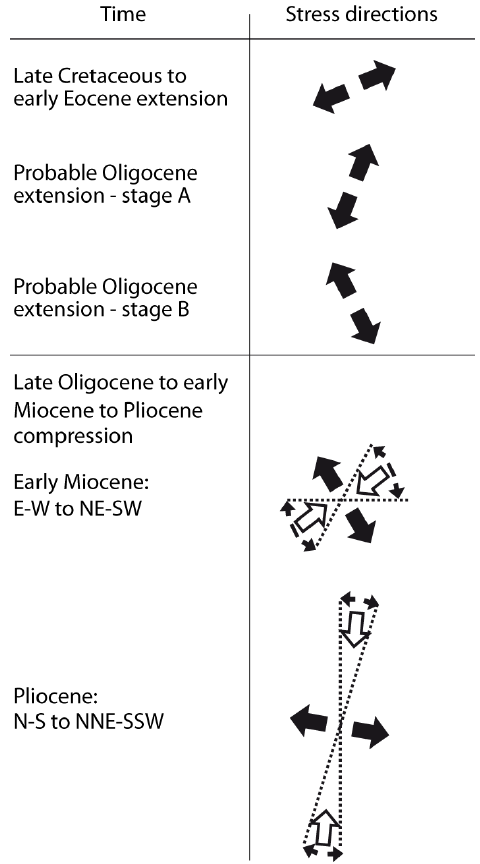
Figure 5. Overview of the changing Late Cretaceous to Pliocene paleostress directions of the eastern Oman Mountains, drawn after [53].